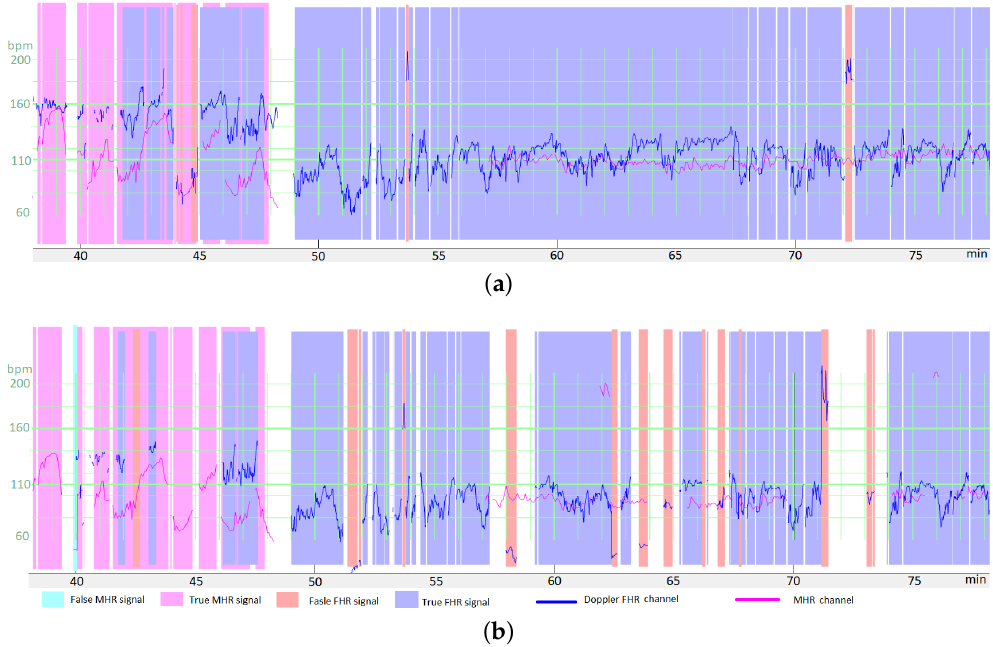
Figure 3. Example of the transformation of a period for data augmentation, with relatively high changes in the Doppler FHR channel (in blue) and the MHR channel (in purple). ( a ) The raw data in a period. ( b ) The period after random transformation. Expert annotations are shown as colored zones. Data augmentation consisted in adding MS and FS on both the FHR and MHR channels. Moreover, both the MHR and the FHR were multiplied by a λ ≈ 0.9. The final signal corresponds to poor quality recordings but remains realistic. It should be noted that the MHR and FHR were not annotated by the experts for the entire recording (either because the experts were uncertain, or the period did not contain difficult-to-interpret